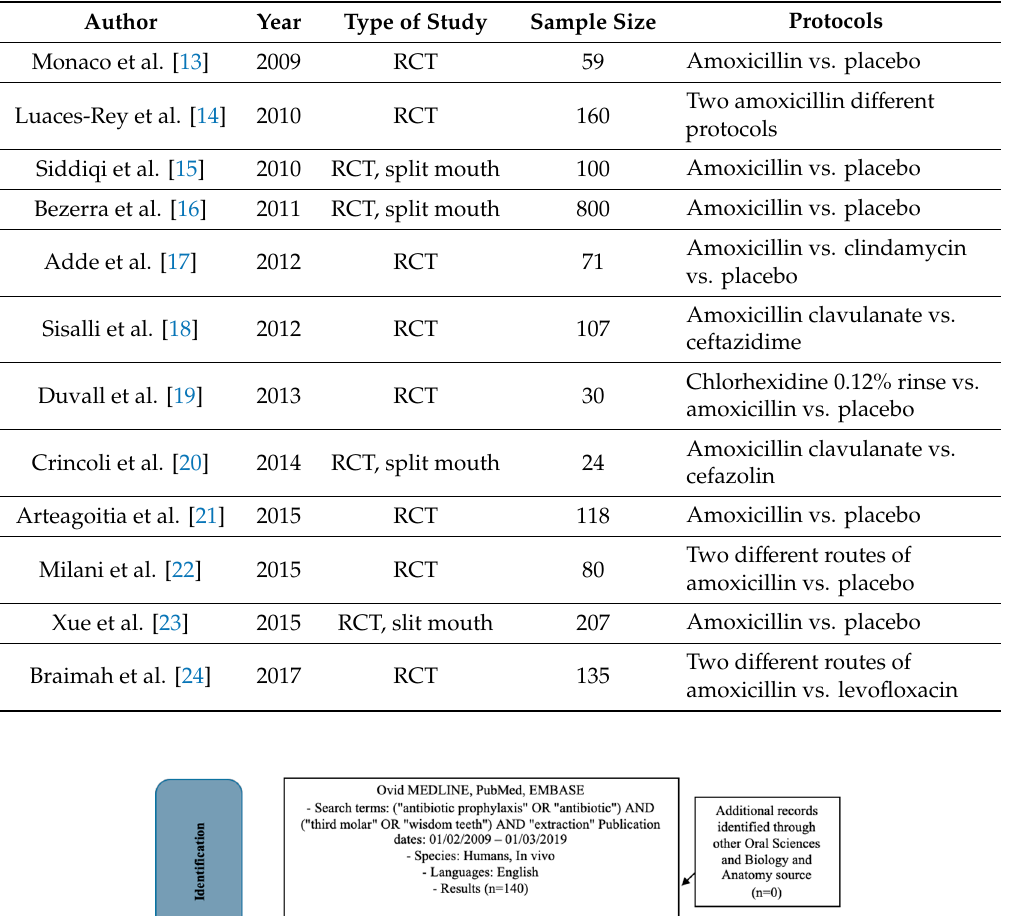
Table 1. Study selection and characteristics.